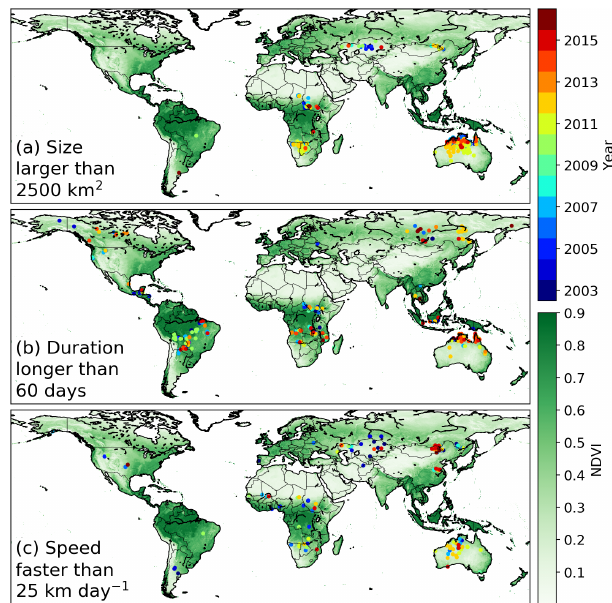
Figure 11. Location and year of the largest, longest and fastest fires over the study period 2003–2016. (a) Fires larger than 2500km 2 , (b) fires longer than 60d and (c) fires with an average veloc- ity higher than 25kmd − 1 . The background image depicts mean MODIS normalized difference vegetation index (NDVI, 2003– 2016), an indicator for large-scale vegetation patterns and available